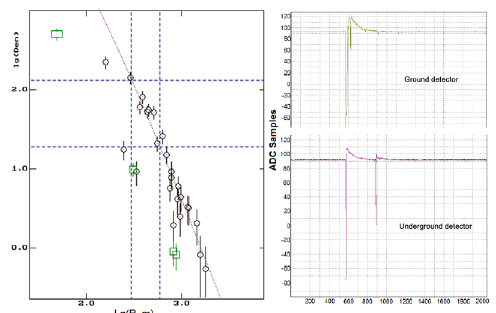
10 19 eV registered at the ≥